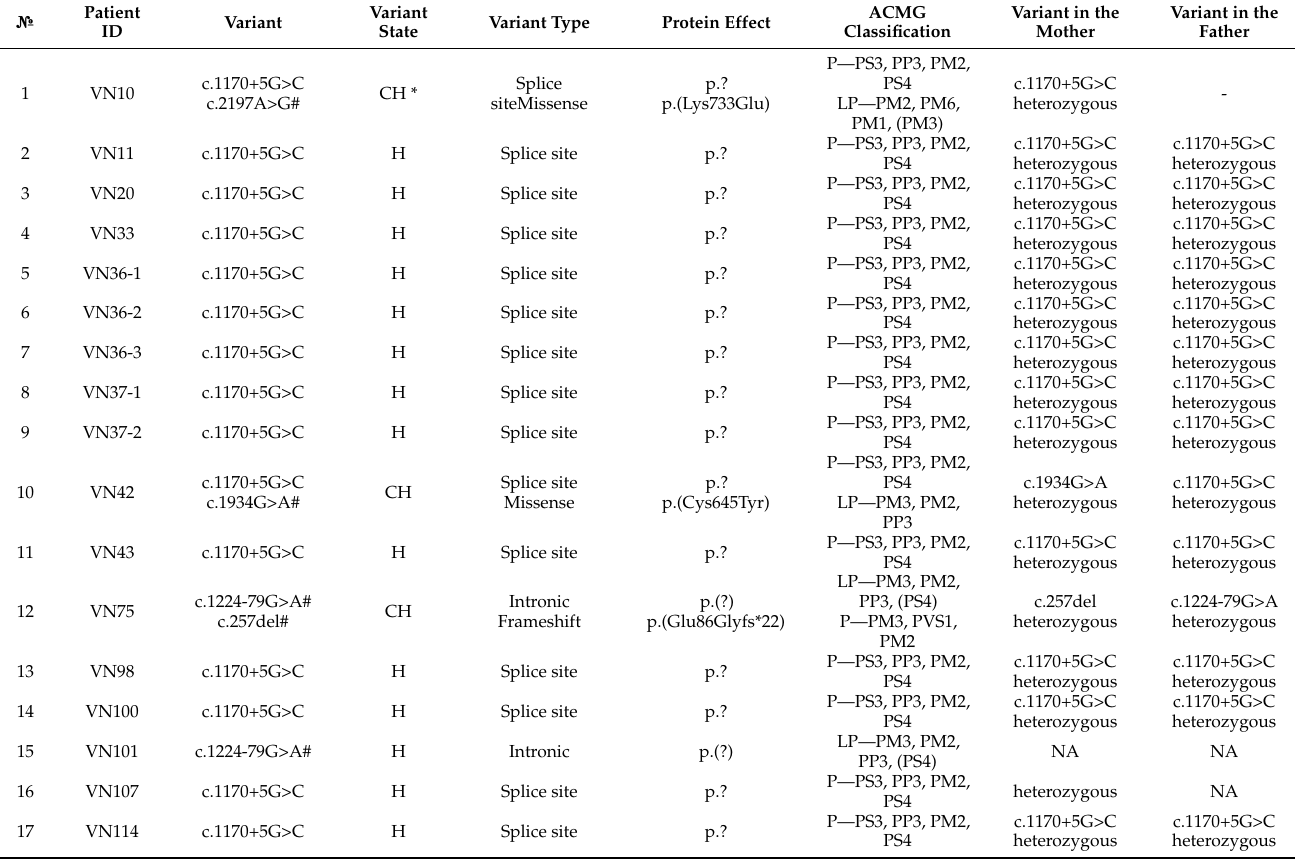
Table 2. Prolyl 3-hydroxylase 1 ( P3H1 , NM_022356.3) variants in Vietnamese osteogenesis imperfecta (OI) patients and presence of the identified variant in the parents. According to the classification system of the American College of Medical Genetics (ACMG), the discovered sequence variants were classified as pathogenic and likely